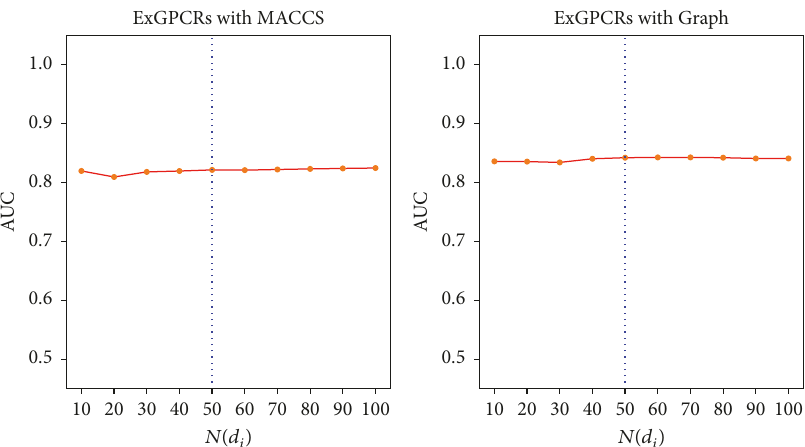
Figure 1: Robustness of SDTRLS with respect to the number of 𝑁(𝑑 𝑖 ) : the dotted line is the default value and its prediction performance.